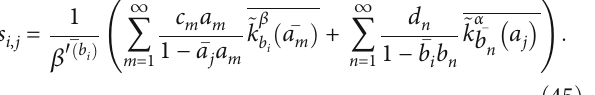
q β j β ′ ð ζ Þj k . Reorder these = k k ζ i i